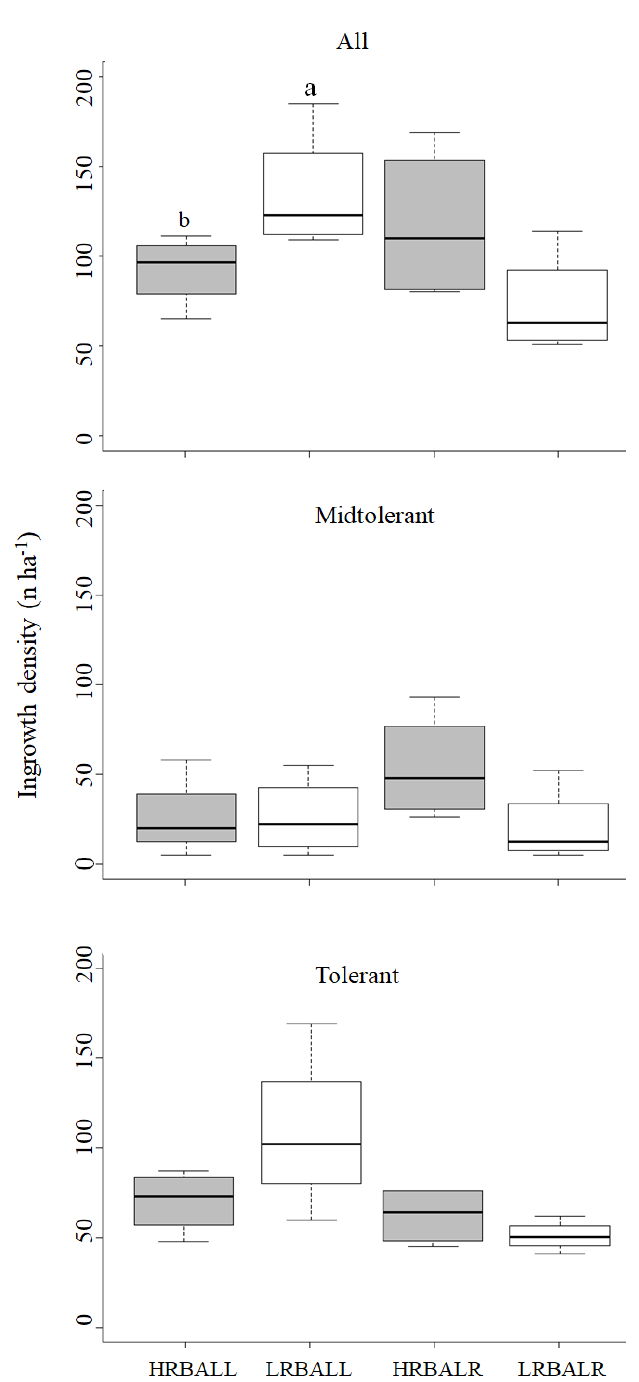
Figure 3. Ingrowth according to functional group by site (LL or LR) and treatment (HRBA or LRBA). Different letters between the same site show significant differences ( p -value < 0.05). Boxes represent the interquartile range (IQR, Q3 minus Q1), including the median of the data, and whiskers include the remaining data.